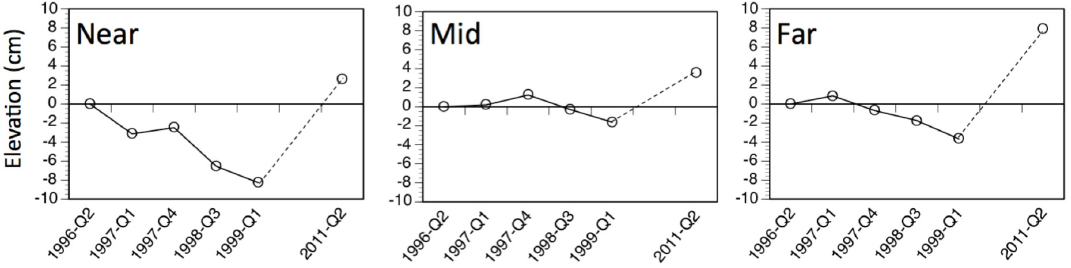
Figure 6. Wetland surface elevation change at the Violet monitoring stations. Q1, Q2, etc. indicate which quarter of the year samples were collected.